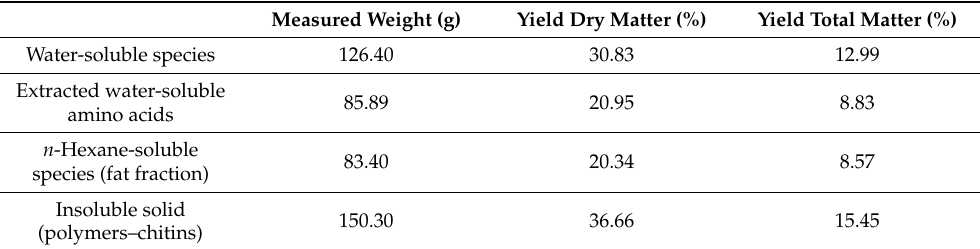
Table 1. Measured yields with respect to the total dry matter of the main fractions extracted with the